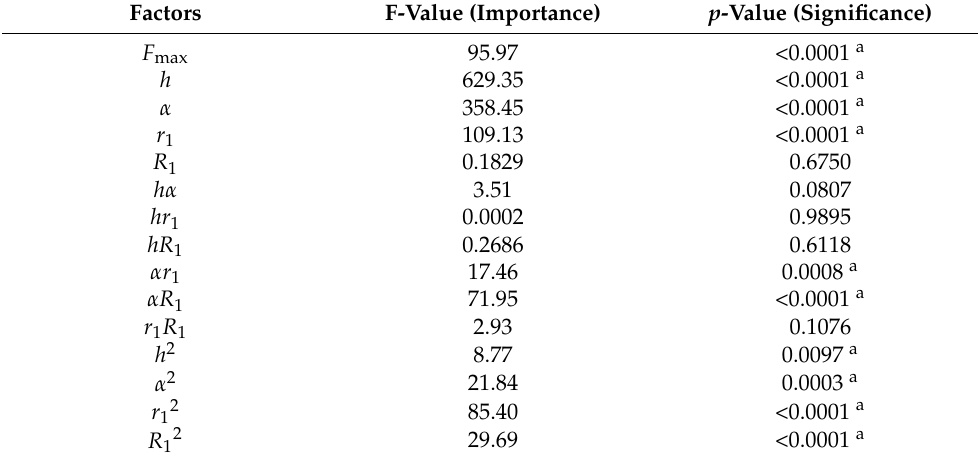
Table 3. Analysis of importance and significance of process parameters on shearing strength ( F max ).